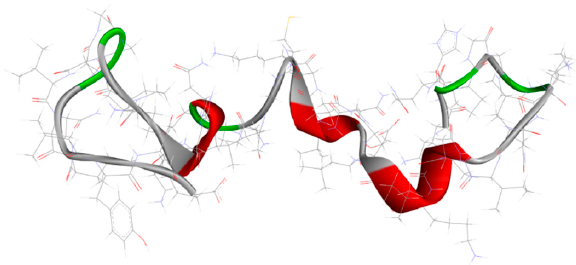
Figure 2. Structure of microtubule-associated protein tau (PDB code: 2MZ7) [64].